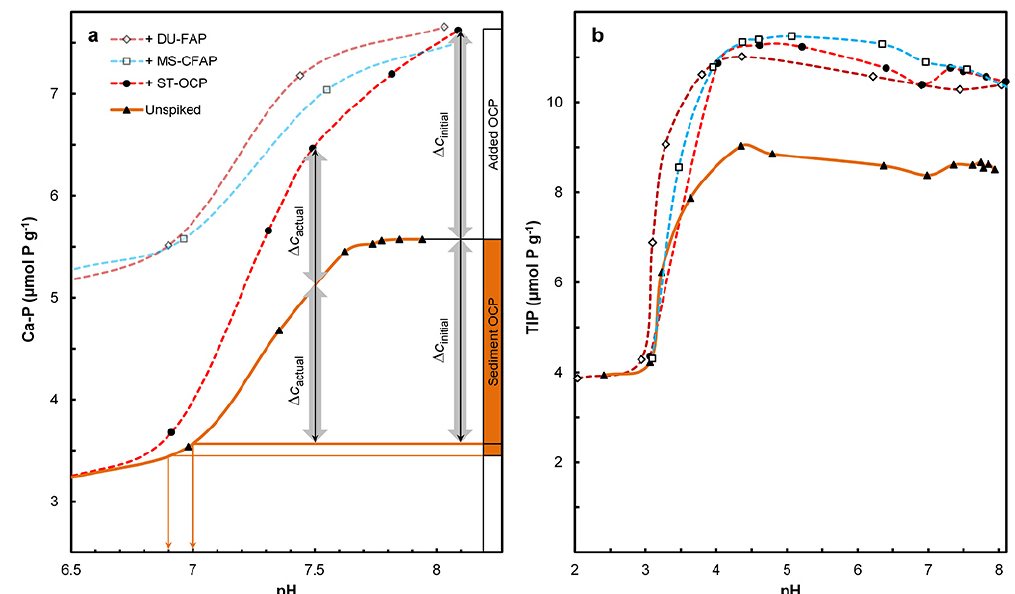
Figure 5. (a) Calculation of Ca-P species dissolution by acidification-induced losses of the Ca-P fraction as indicated for OCP. Differential OCP dissolution occurred at ca. pH 7 (thick orange arrow) and a slightly lower pH (6.9; thin orange arrow) was preferable to calculate the OCP content (see text). Curves were fitted by piece-wise cubic hermite interpolating polynomial to calculate selective losses of species ( 1c loss = 1c initial – 1c actual ) at different pH values. Grey arrows denote initial and actual concentrations (exemplified for pH 7.5) of added OCP ( + ST-OCP) and sediment OCP (unspiked). Superimposed black arrows denote corresponding concentrations of total OCP (added OCP plus sediment OCP). Calculated loss percentages for different P species at different pH values are given in Table 2. Standard addition of FAP and CFAP is shown for comparison ( + DU-FAP; + MS-CFAP; insignificant dissolution in the range of OCP dissolution). (b) Acidification- induced changes of total inorganic P (TIP = Ca-P + Al / Fe-P) for unspiked sediment and standard additions of OCP, FAP and CFAP (same symbols as in a